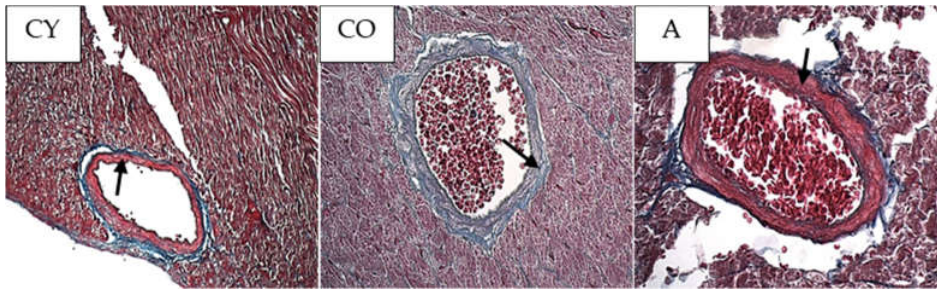
Figure 2. Myocardium. Coronary arteries of the left ventricle of the rat heart, azan staining, magni- fication × 200; black arrows indicate tunica media.